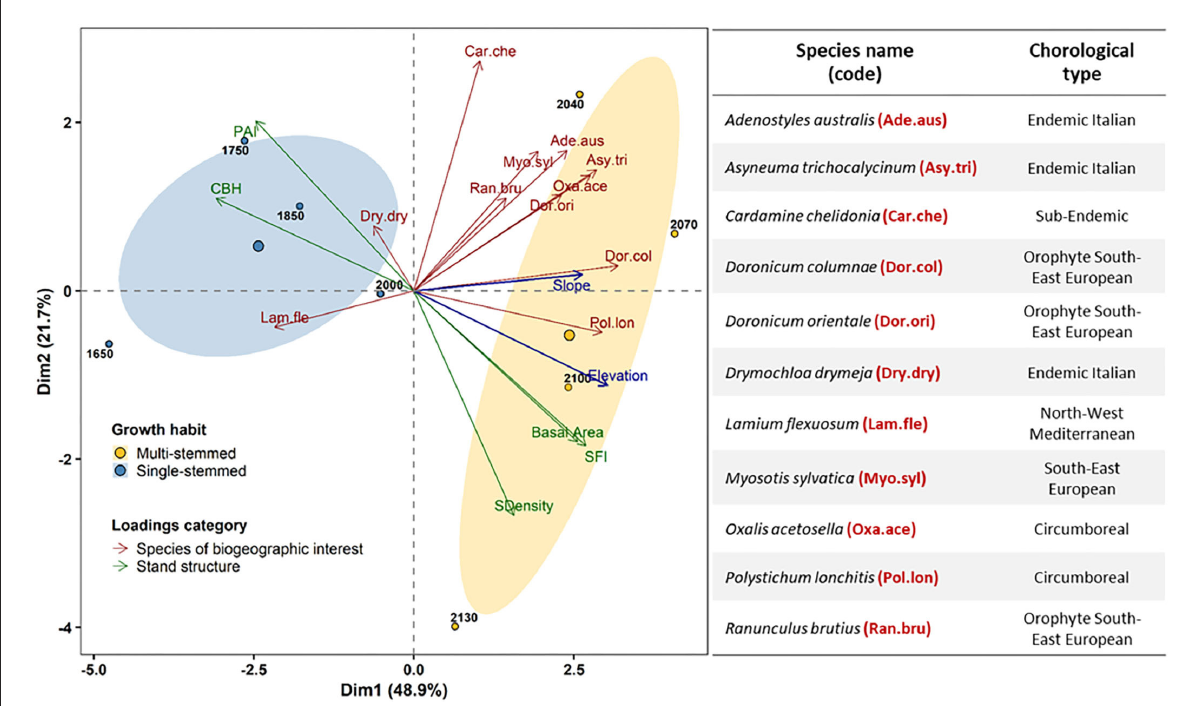
FIGURE5 Relationship among abundance of biogeographic interests target herbaceous species and topographic and structural attributes of Fagus sylvatica stands covering the north-western slope of the Serra del Prete mountain. Circular points represent plane coordinates of altitudinal sampling plots according to growth habit (supplementary qualitative category): yellow for multi-stemmed and black for single-stemmed. Arrows represent loadings (variables), colored according to the category of forest canopy attributes: red for target species abundance and green for stand structure metrics. Dark blue arrows represent continuous supplementary topographic variables (elevation and slope). Ellipses are drawn around the coordinates of the centroid of each growth habit with a 95% confidence (CI) band. Stand structure metric: CBH, live crown base height; PAI, plant area index; basal area, stand basal area; SDensity, stem density; SFI, stem form index. The table on the left includes the scientific name, code, and chorological type for each herbaceous species of biogeographic